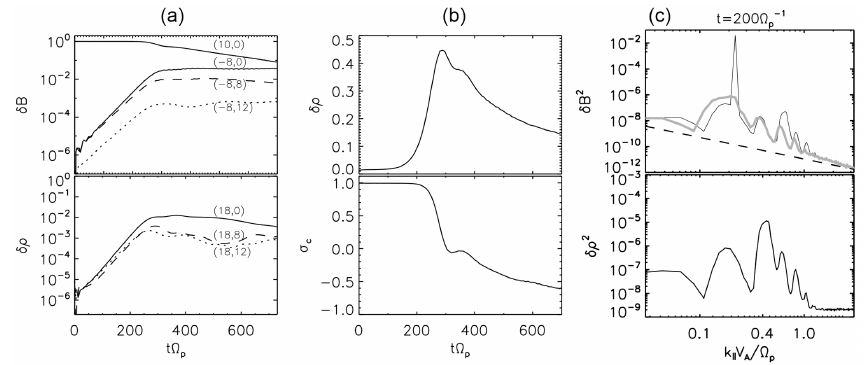
Figure 2. (a) Time evolutions of the Alfvén pump mode (10,0), the field-aligned Alfvén daughter mode ( − 8,0), and the ion acoustic daughter mode (18,0) are given by solid lines in the top and bottom panels, respectively. Two moderate obliquely propagating daughter waves are also drawn by dashed and dotted lines. (b) Time evolution of the rms density fluctuations (top) and the cross-helicity (bottom). (c) Power spectrum in the k (cid:107) wavenumber domain for the decomposed magnetic field (top) and density (bottom) fluctuations before the nonlinear saturation of the decay instability. The sunward (antisunward) propagating left-handed fluctuations are drawn in black (gray). The dashed line describes − 5 / 3 power laws of the normalized wavenumber k (cid:107) .